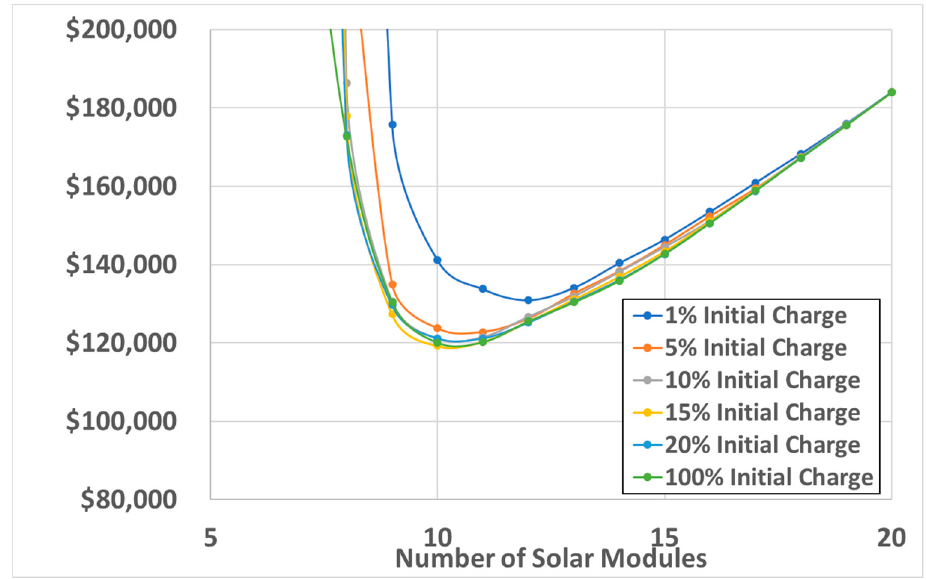
Figure 8. Changing initial charge for IES systems given November, five systems, Indianapolis, and 0.1% LPSP.